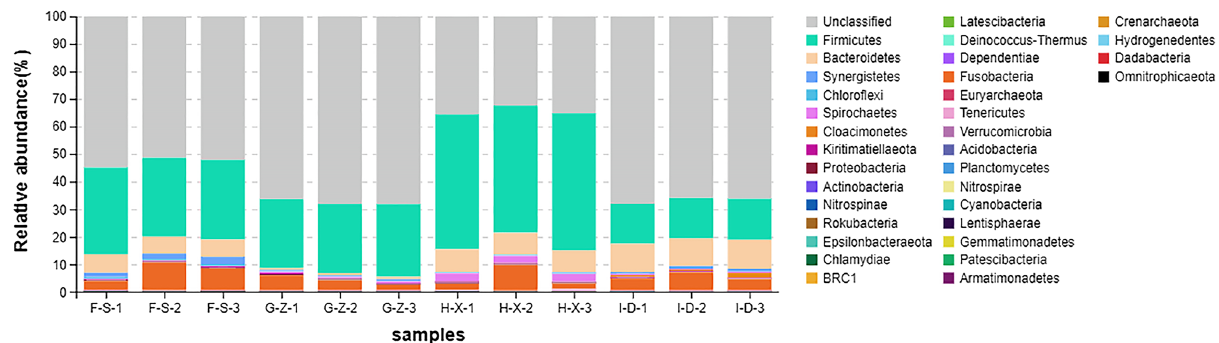
Figure 2. Stack diagram showing the species distribution of bacteria in pit mud from F-S, G-Z, H-X and I-D at the phylum level.